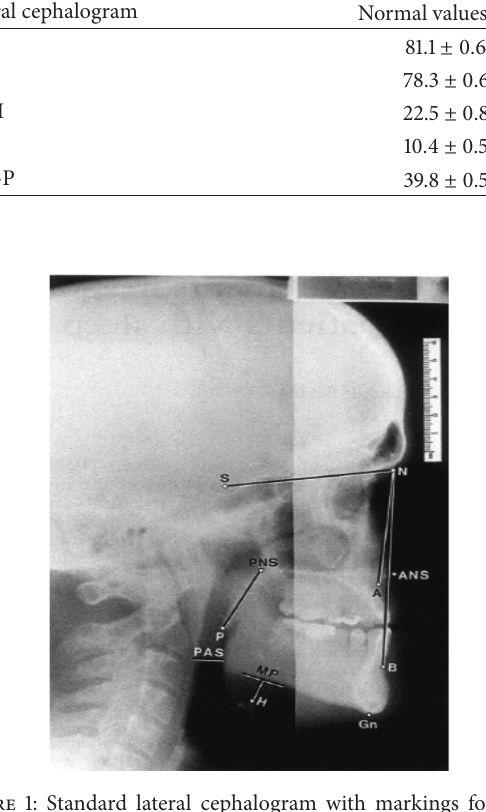
Figure 1: Standard lateral cephalogram with markings for SNA, SNB, PAS, MP-H, and PNS-P. Angle SNA: the angle from sella at the centre of pituitary fossa of sphenoid bone to nasion and the most posterior point on the curve between anterior nasal spine and supradentale of the maxilla. Angle SNB: the angle from sella, nasion, and the point of greatest concavity on the anterior surface of mandibular symphysis. PAS (posterior airway space): the distance from base of tongue to the posterior pharyngeal wall at the level of C2 vertebra. PNS-P (length of the soft palate): the distance from the most posterior point on the sagittal plane of hard palate (PNS) to the tip of the soft palate (P). MP-H (mandibular plane to hyoid bone): measured at the mentum (Me) as the line joining MP (mandibular plane) to H (the most anterosuperior point of the hyoid bone). MP: the line joining (Me) and Go (Gonion, most lateral external point at